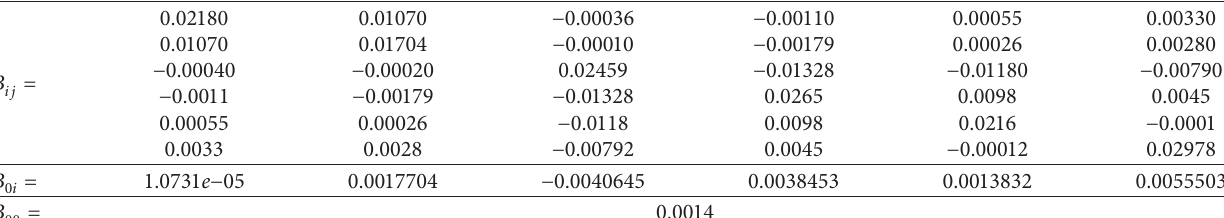
Table 2: Coefficient matrix of transmission B-loss for the test system: IEEE 30 bus.